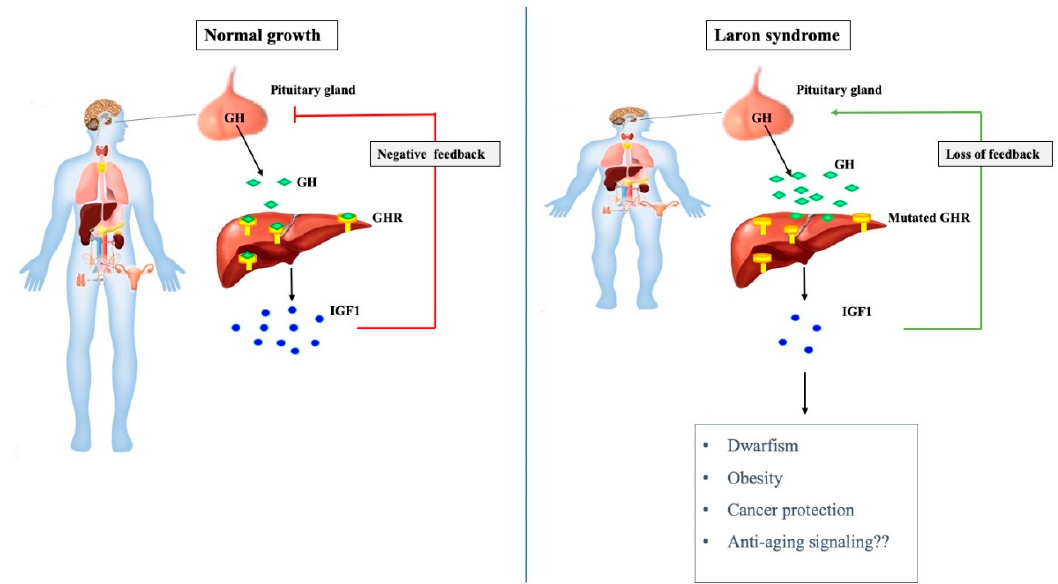
Figure 1. The growth hormone-IGF1 axis in normal and pathological growth. Pituitary-produced growth hormone (GH) stimulates insulin-like growth factor-1 (IGF1) secretion from the liver, leading to bone elongation and longitudinal growth ( left panel ). Laron syndrome (LS) is associated with mutation of the GHR gene, as a result of which the liver (and, most probably, additional extrahepatic tissue) is no longer able to produce IGF1 at physiological levels in response to GH stimulation ( right panel ). Abrogation of IGF1 biosynthesis leads to impaired growth and concomitant relaxation of negative feed-back regulation of GH production at the pituitary gland. Loss of inhibitory control results in very high circulating GH levels. In addition to short stature, LS is associated with obesity and protection from cancer. Enhanced longevity has been demonstrated in animal models of LS (‘Laron’ mouse).